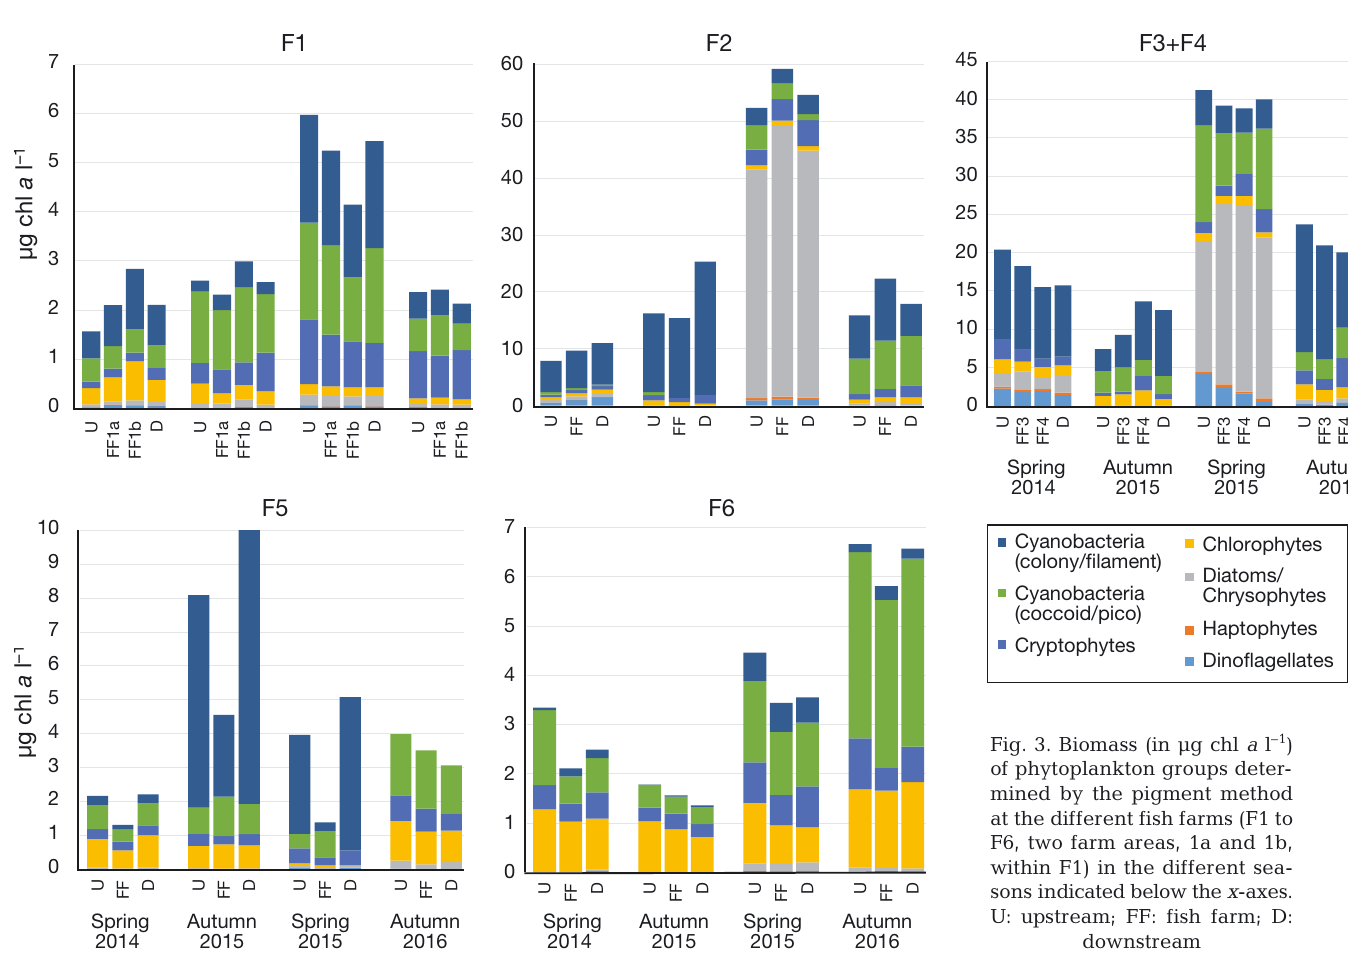
(Fig. 4) where Fragilaria sp. dominated. The chl a biomasses determined by the pigment method of cyanobacteria (sum of filamentous/colony forming and coccoid/pico-sized cyanobacteria), cryptophytes, chlorophytes, and diatoms were significantly corre- lated with the organism numbers of the respective groups counted in the microscope (r = 0.52, p < 0.001; r = 0.46, p < 0.001; r = 0.38, p < 0.01; and r = 0.86, p < 0.001, respectively).